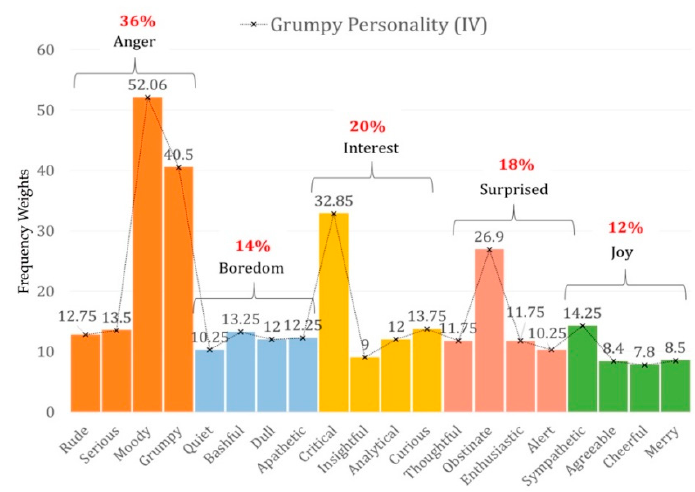
Figure 8. Grumpy Personality (Factor IV): behaviors at Level 3.